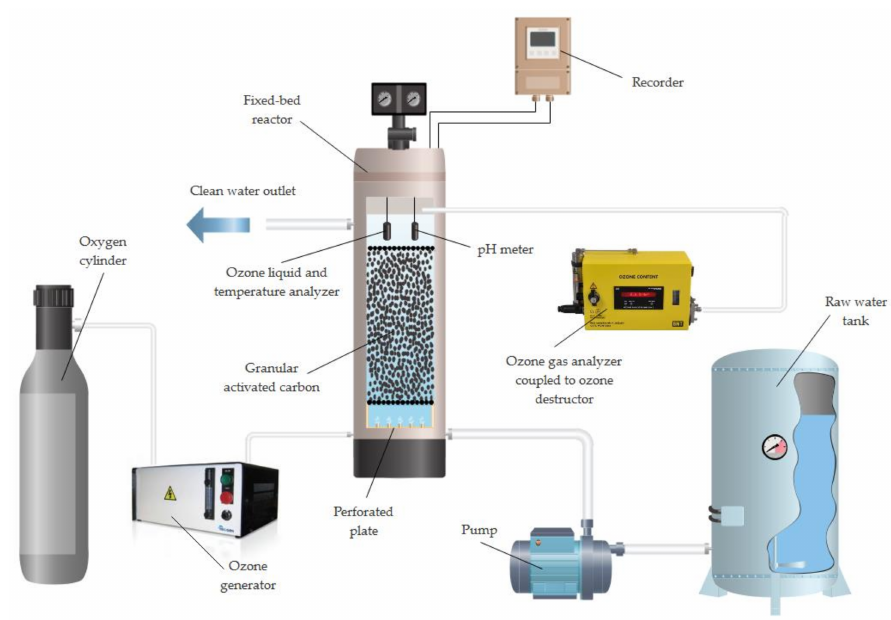
Figure 6. Experimental setup used to carry out ozonation and Ad/Ox